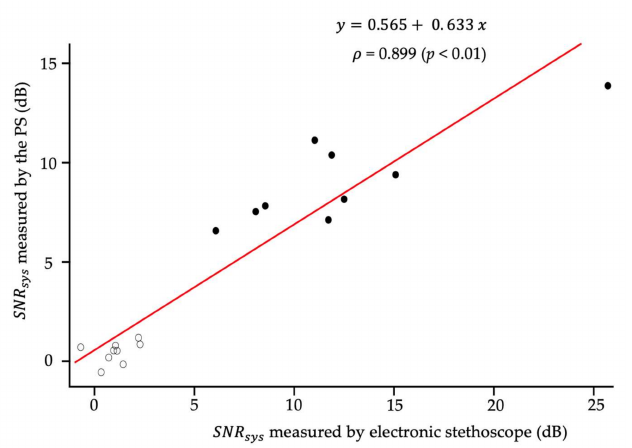
Figure 6. Scatter plot, linear regression line, and Spearman’s correlation coefficient between the signal-to-noise ratio ( SNR sys ) of a systolic murmur recorded by the piezoelectric sensor and that recorded by an electronic stethoscope (n = 18). Black circle indicates the SNR sys of the congenital heart defects (CHDs) group, while the white circle shows the SNR sys of the control group. The red line indicates the regression